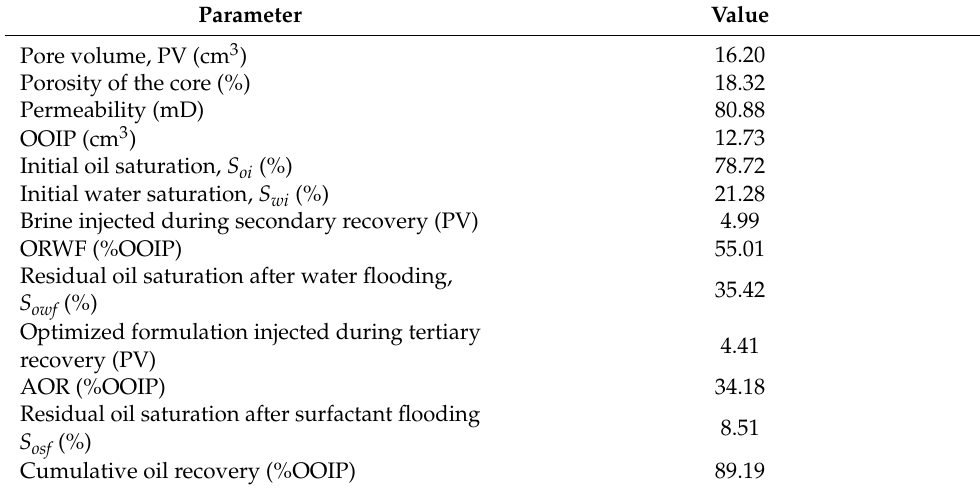
Figure 2. Dynamic TGA thermograms of the eutectic mixture (black, dotted line), AOT (red, dashed line), and PEG-600 (solid, blue line).